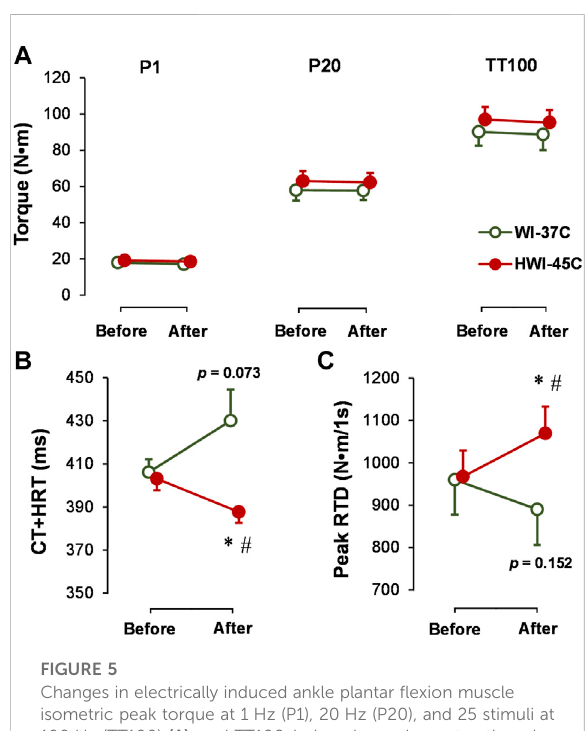
FIGURE 4 Changes in maximal voluntary contraction torque (MVC) (A) , central activation ratio (B) , and root mean square (RMS) (C) , and mean frequency (MnF) (D) of the sEMG signal of the soleus muscle during the 5-s MVC before and after whole-body immersion inwatertemperaturesof37 ° C(WI-37 ° C)and45 ° C(HWI-45 ° C).* p < 0.05, HWI-45 ° C compared with before; # p < 0.05, HWI-45 ° C compared with WI-37 ° C. Values are expressed as mean and SD.